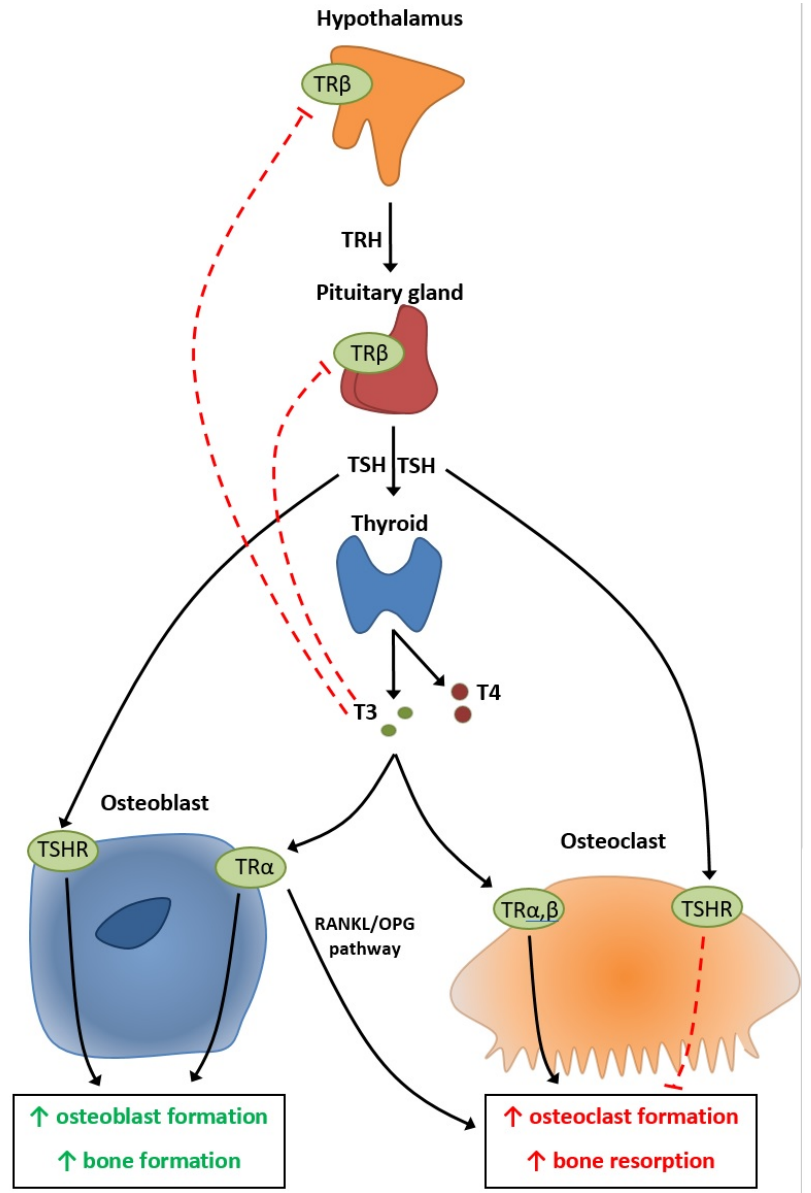
Figure 1. Physiopathology of the hypothalamic–pituitary–thyroid axis on bone metabolism. OPG = osteoprotegenrin; RANKL = receptor activator of nuclear factor kappa ‐ B ligand; TRH = thyrotropin ‐ releasing hormone; TSH = thyroid ‐ stimulating hormone; TSHR = thyroid ‐ stimulating hormone receptor.